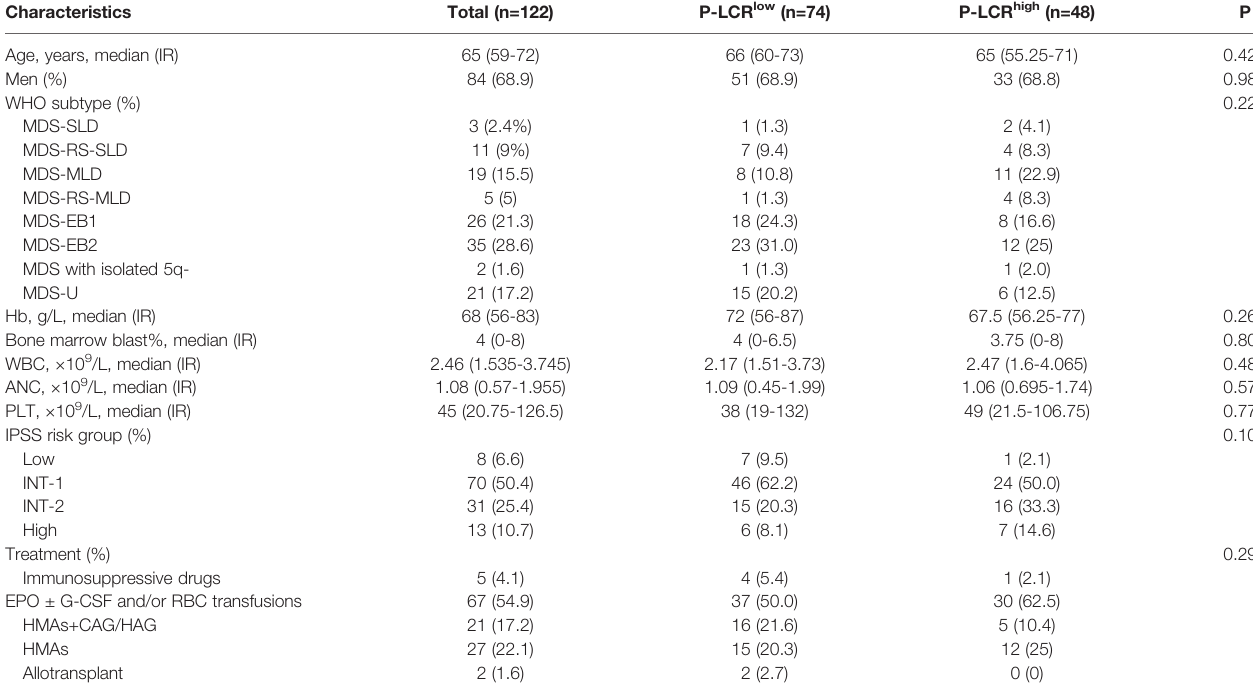
TABLE 1 | Characteristics of 122 subjects with MDS.